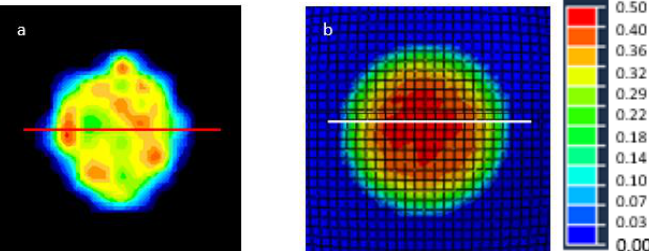
Figure 15. Layers and surface pressure distributions of the real object ( a ) and model object ( b ) for an apple dropped from a height of 30 mm on a concrete substrate in a section passing through the central point of contact.